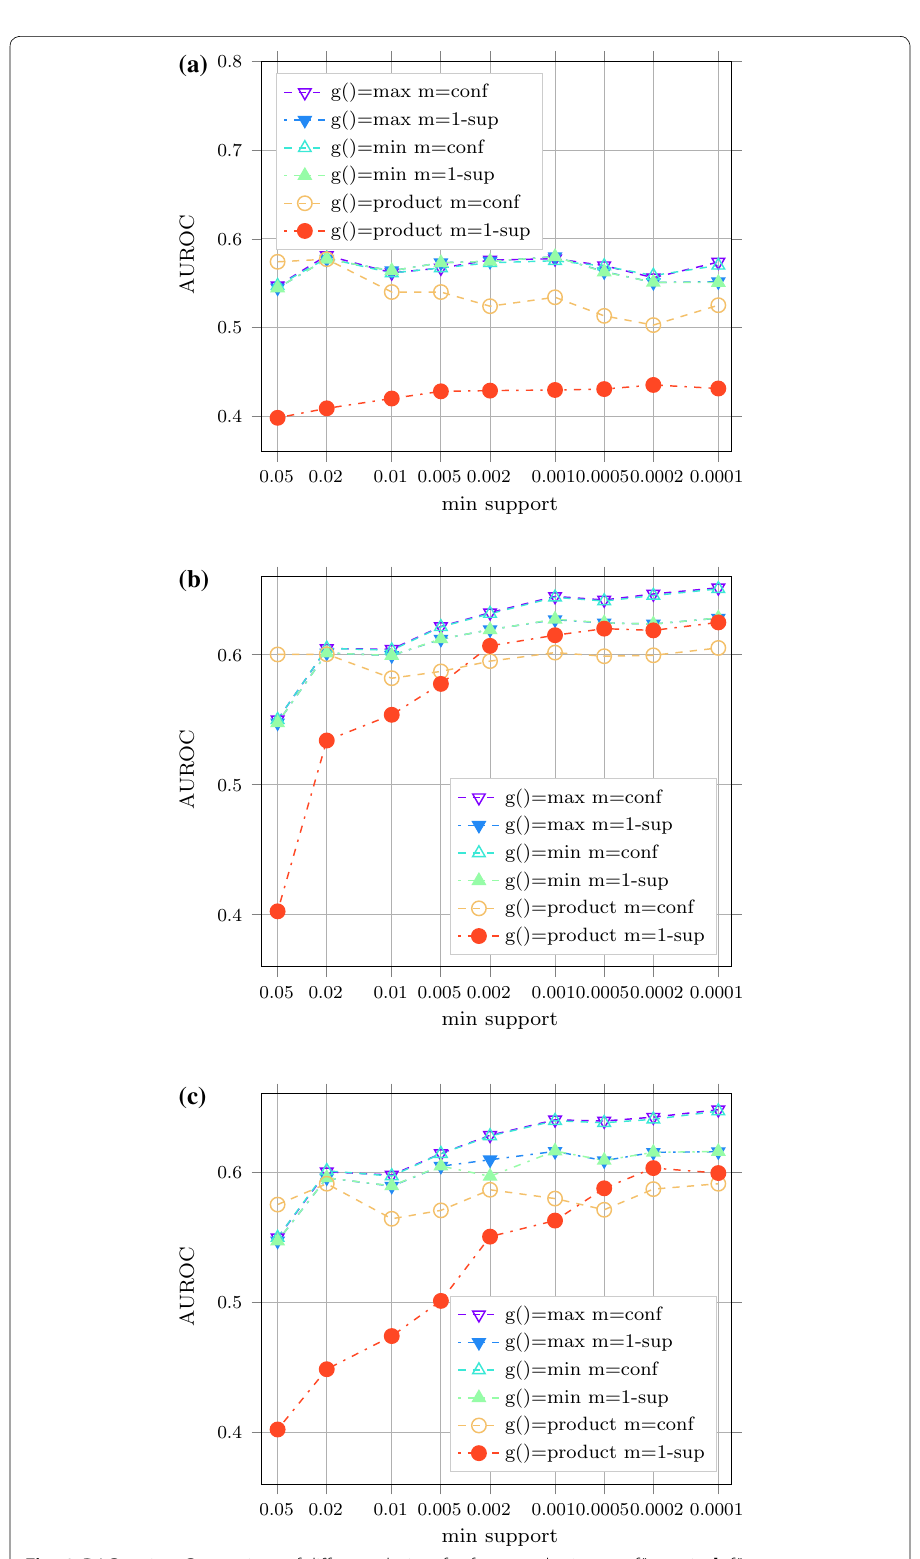
Fig. 6 DAC tuning. Comparison of different choices for f , g , m and minsup . a f() f() =